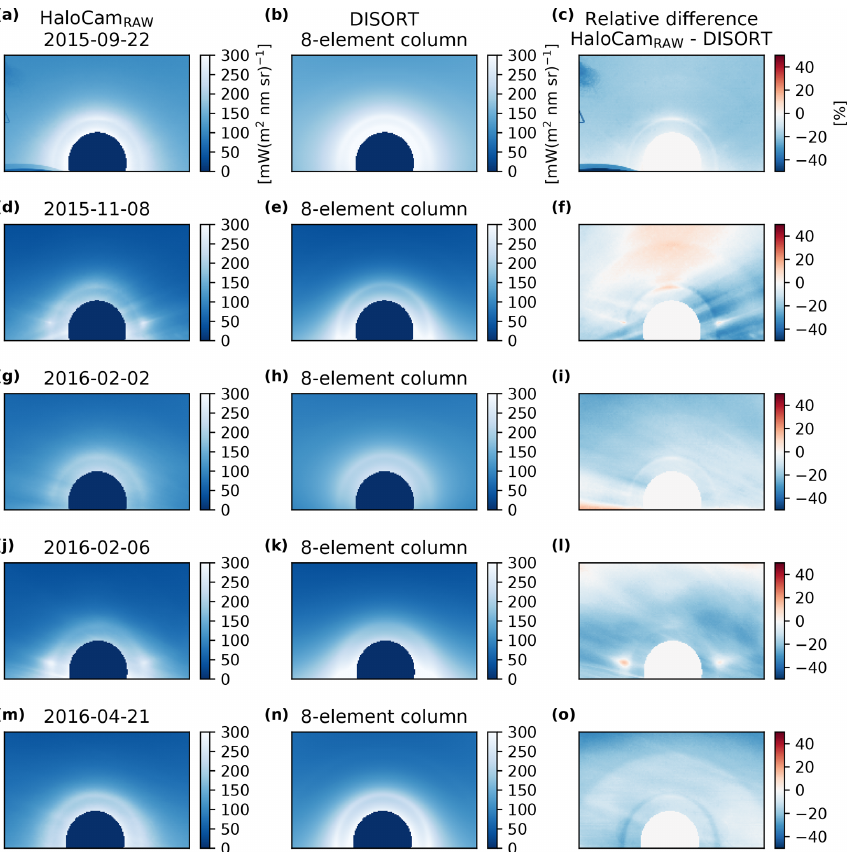
Figure 9. Same as Fig. 8, for selected days and 8-element columns, the overall best-matching ice crystal habit for both the 22 and 46 ◦ halo